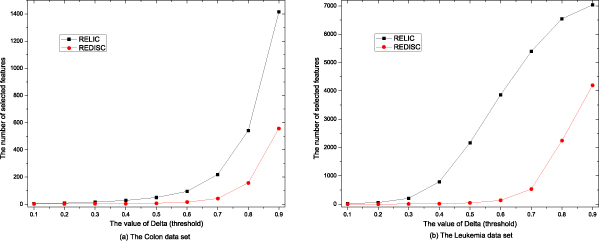
The number of selected genes by performing REDISC and RELIC with different parameters.